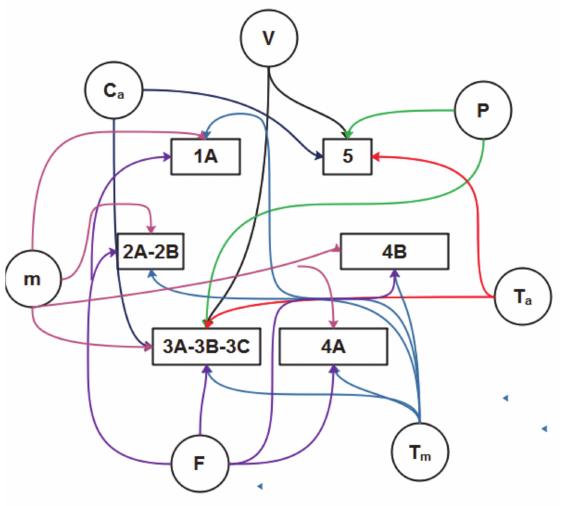
Figure 3. Couplings among process variables (circles), and process nodes (boxes). F —sugar flow; m—sugar mass; C a —airborne sugar dust concentration; V —volume available; P —pressure; T a —air temperature; T m —temperature of mechanical